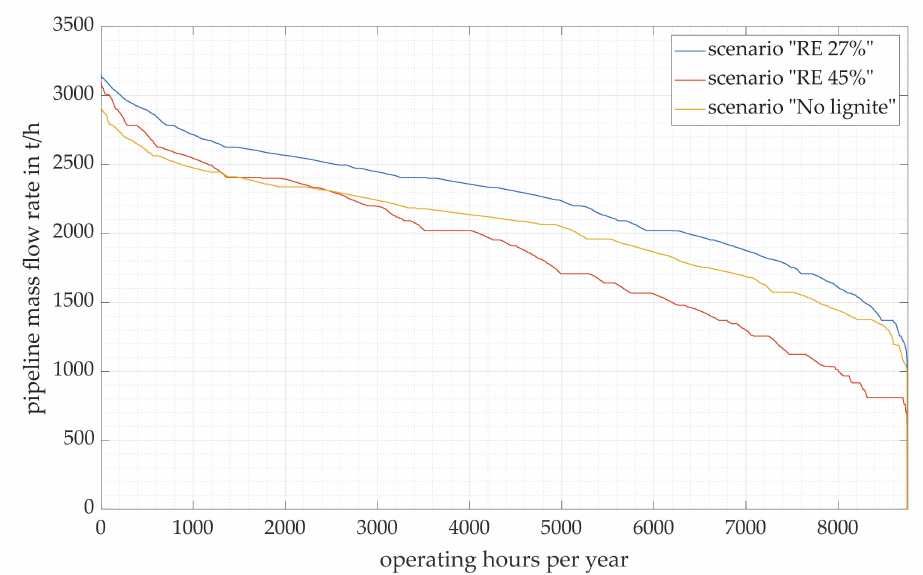
Figure 11. Modelled occurrence of di ff erent pipeline mass flow rates at the trunk line entry per year—a comparison between the energy mix